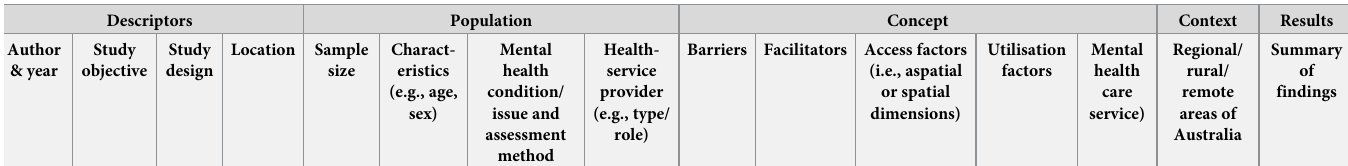
Table 3. Indicative charting form for data